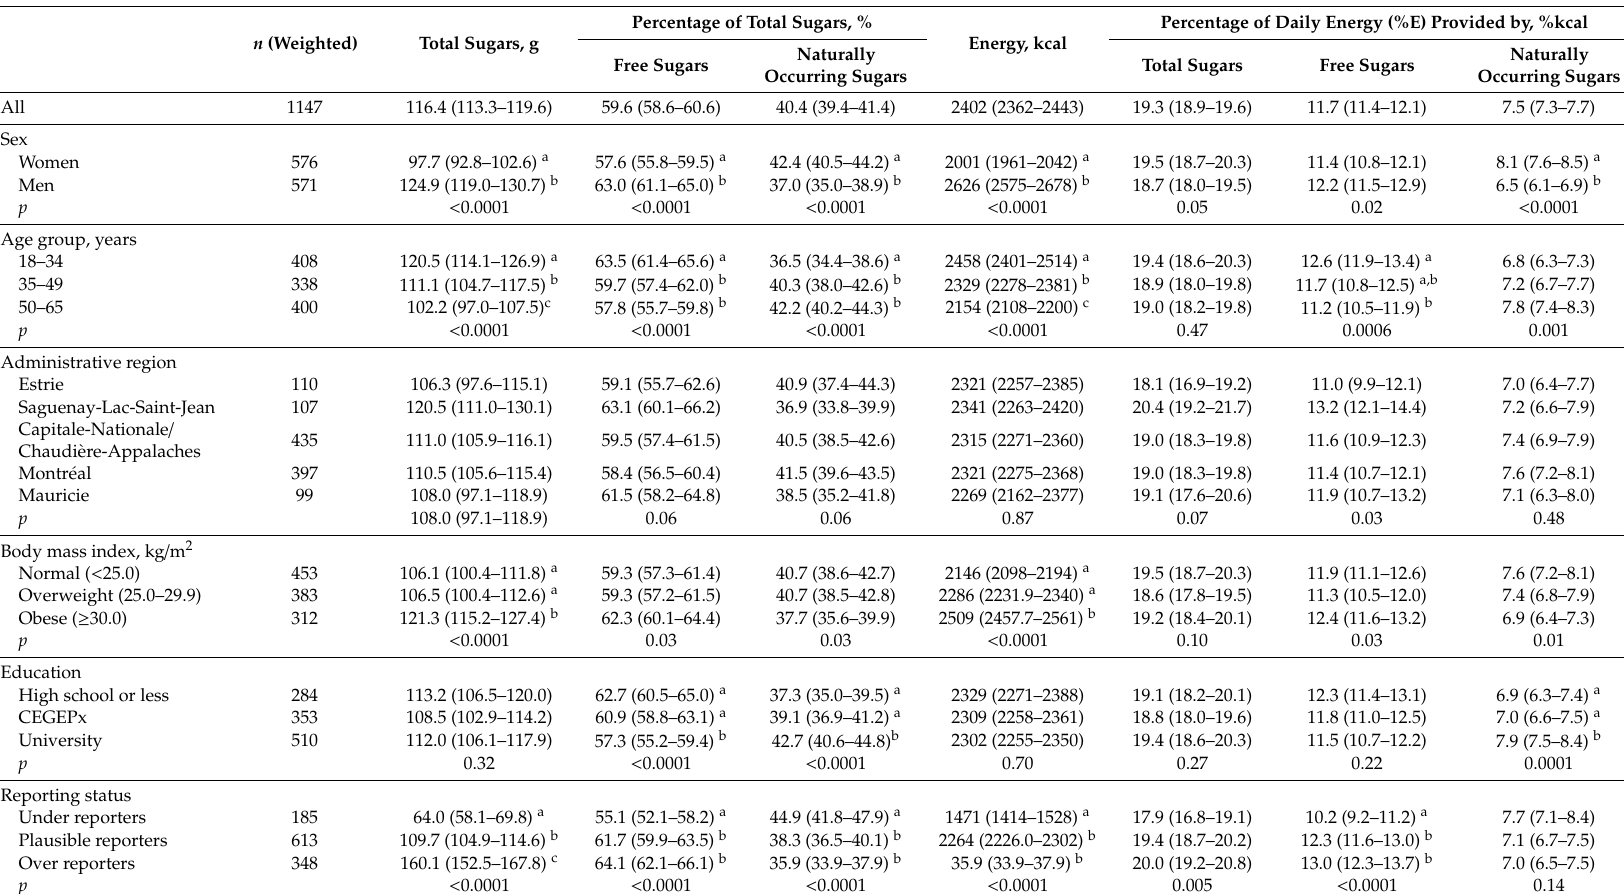
Table 2. Mean (95% CI) intakes of total, free and naturally occurring sugars, expressed in grams, percentages of total sugars and percentages of energy they provide, in a representative sample of French-speaking adults of the Province of Qu é bec,